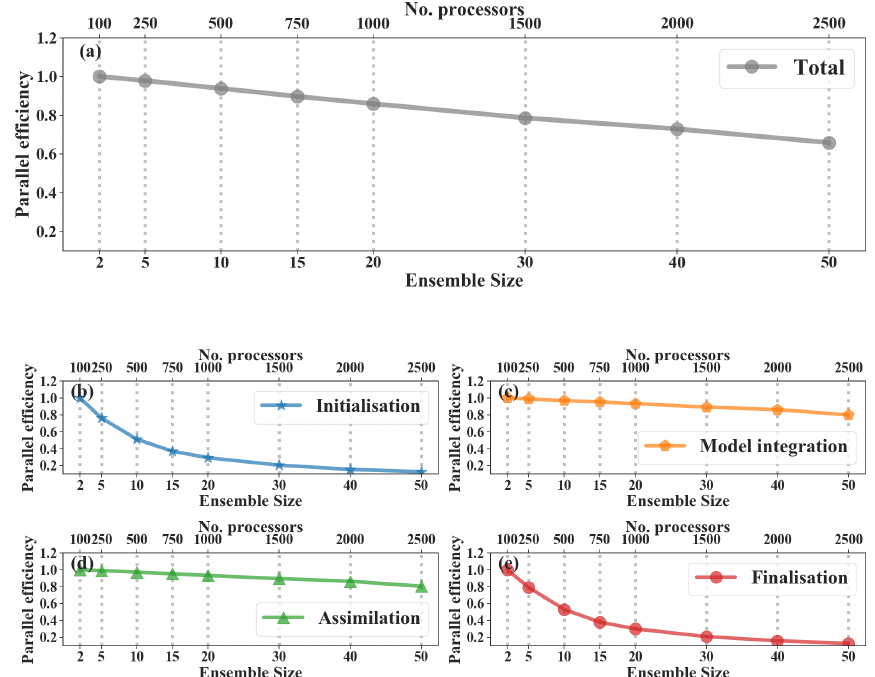
Figure 6. Weak scaling behavior for the NAQPMS-PDAF. The gray line shows the parallel efficiency for all processes. The blue line shows the parallel efficiency for initialization. The orange line shows the parallel efficiency for model integration. The green line shows the parallel efficiency for assimilation. The red line shows the parallel efficiency for finalization. A total of 50 processors are apportioned to each ensemble